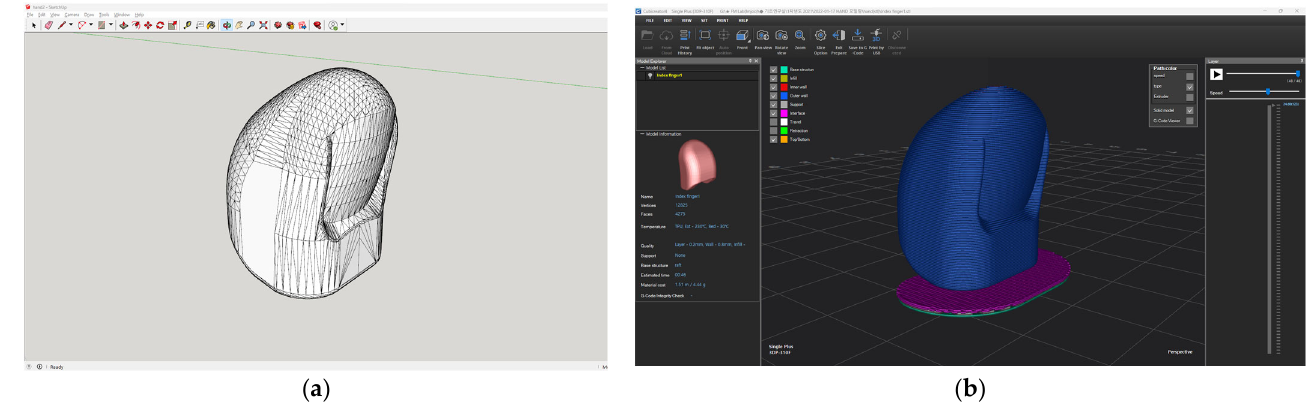
Figure 1. Modeling image of 3DP index fi ngertips: ( a ) Sketchup software; ( b ) Slicing